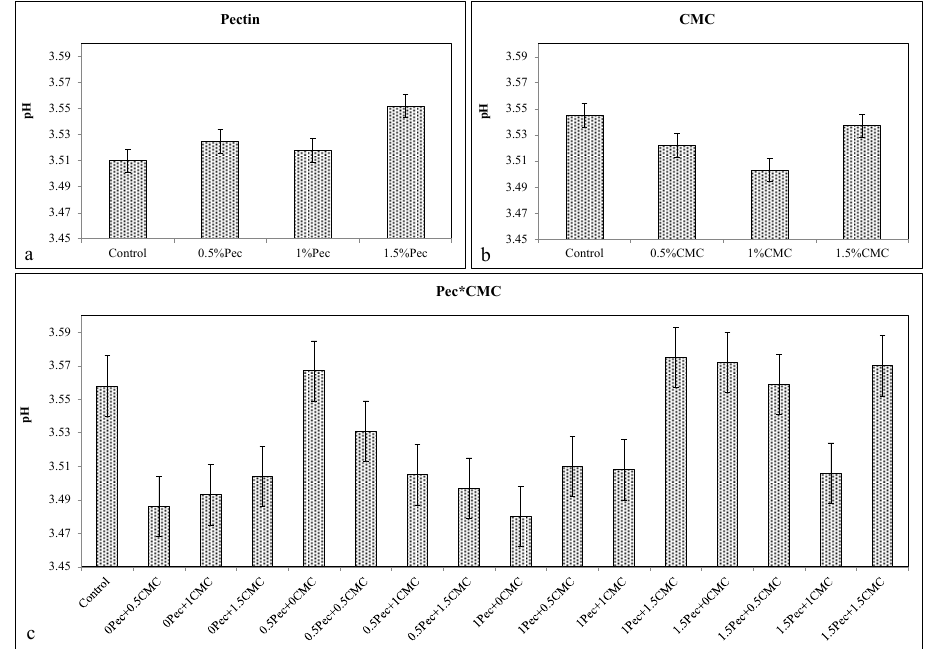
Figure 5. Effect of 0 (control), 0.5 (0.5% Pec), 1 (1% Pec) and 1.5 (1.5% Pec) % pectin-based edible coatings ( a ), 0 (control), 0.5 (0.5% CMC), 1 (1% CMC) and 1.5 (1.5% CMC) % carboxymethylcellulose-based edible coatings ( b ) and their combinations ( c ) on pH during cold storage period. Data are the “estimated marginal means ±95% confidence intervals”. The columns with non-overlapping error bars are significantly different ( p ≤ 0.05).